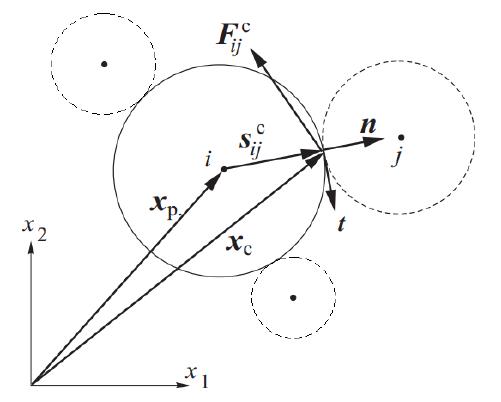
Figure 4. Definition of interparticle interaction